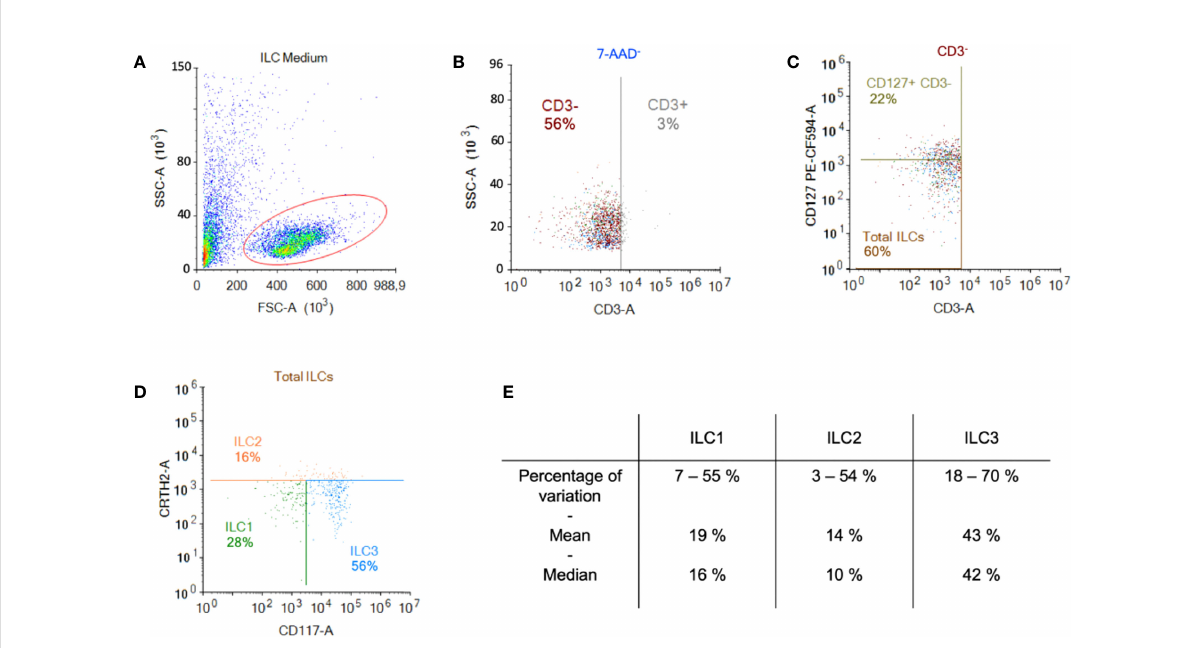
FIGURE 1 Enrichment and identi fi cation of ILCs from peripheral blood. Freshly isolated PBMCs were used for the negative selection of ILCs. (A) Population of cells post-negative selection. Of these, ~50% were lymphoid based on their size and granulosity; (B) from the lymphoid population, we gated on the CD3 - population and (C) in the CD3 - population the majority of cells were CD127 + (MFI for CD127 + was 2269 vs. 668 for CD127 - ); (D) from the CD3 - population we also screened for the presence of CRTH2 and CD117, which delimits the ILC populations; (E) cumulative data from 60 donors showed the range of percentage, the median, and the mean of each ILC